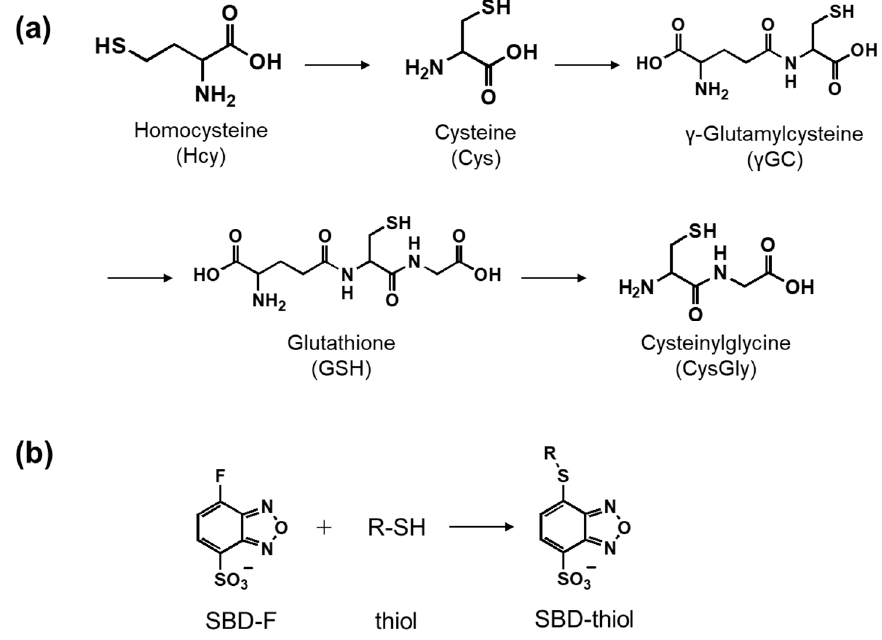
Figure 1. ( a ) Metabolic pathway of thiols and ( b ) derivatization reaction of SBD-F with thiols.